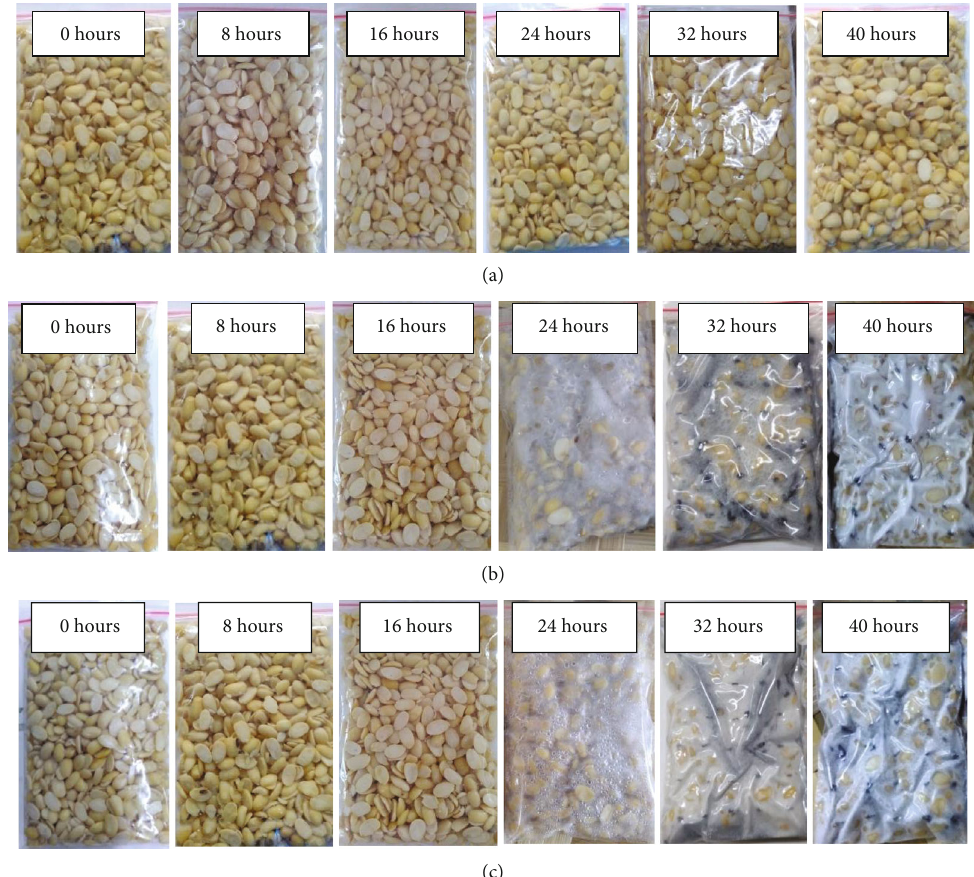
Figure 2: The appearance of soybeans inoculated with a single culture of S . cerevisiae (a), a single culture of R . oligosporus (b), and mixed culture of both microorganisms (c) during tempeh fermentation.